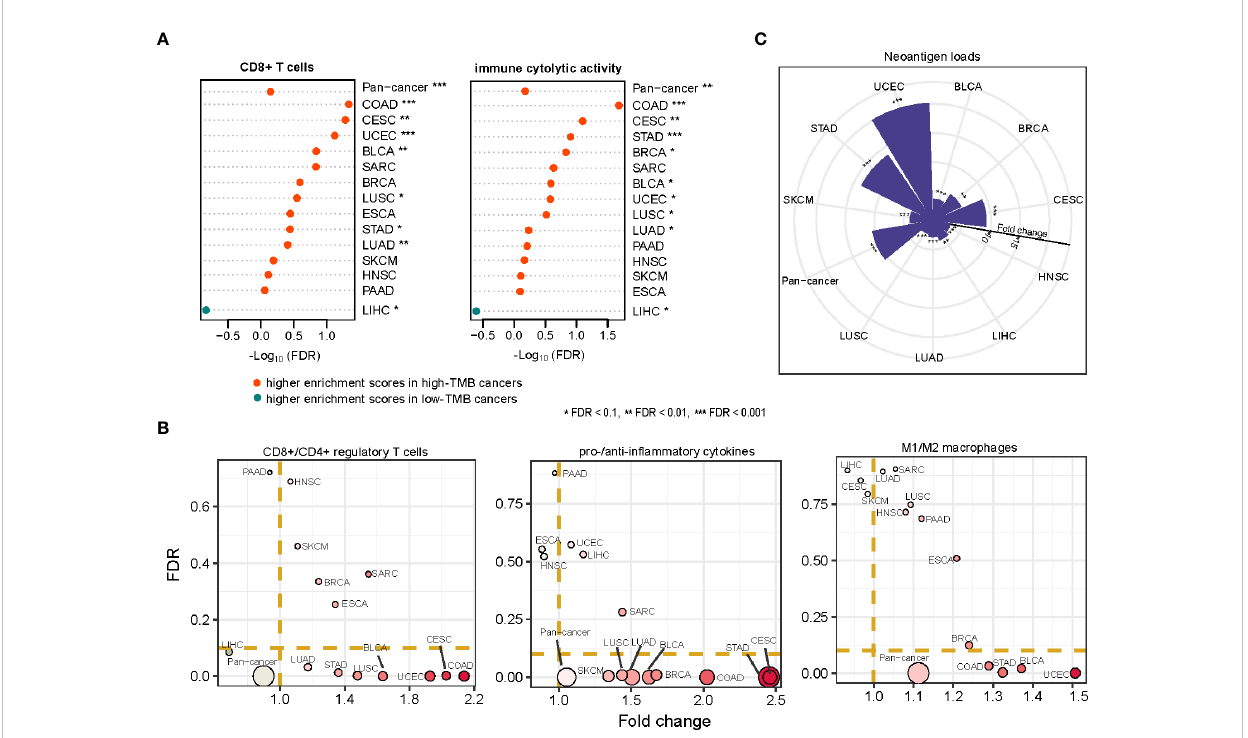
FIGURE 7 Association between TMB and antitumor immune response in cancer. The enrichment levels of antitumor immune signatures (CD8+ T cells and immune cytolytic activity) (A) , the ratios of immunostimulatory/immunoinhibitory signatures (CD8+/CD4+ regulatory T cells, pro-/anti-in fl ammatory cytokines, and M1/M2 macrophages) (B) , and the neoantigen loads (C) likely to be higher in high-TMB than in low-TMB cancers. The one-tailed Mann-Whitney U test (A, C) and two-tailed Student ’ s t test (B) FDRs are